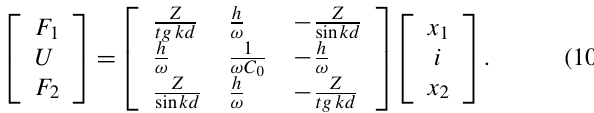
electrical elements in a single, free-standing piezoelectric plate, is shown in Eq.